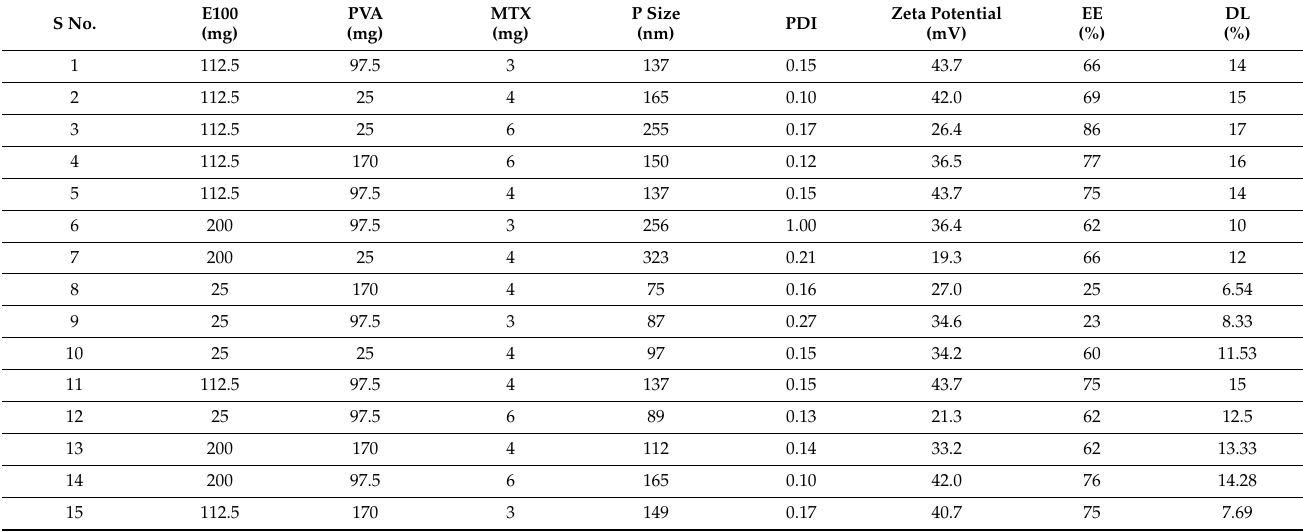
Table 1. Optimization of MTX-loaded